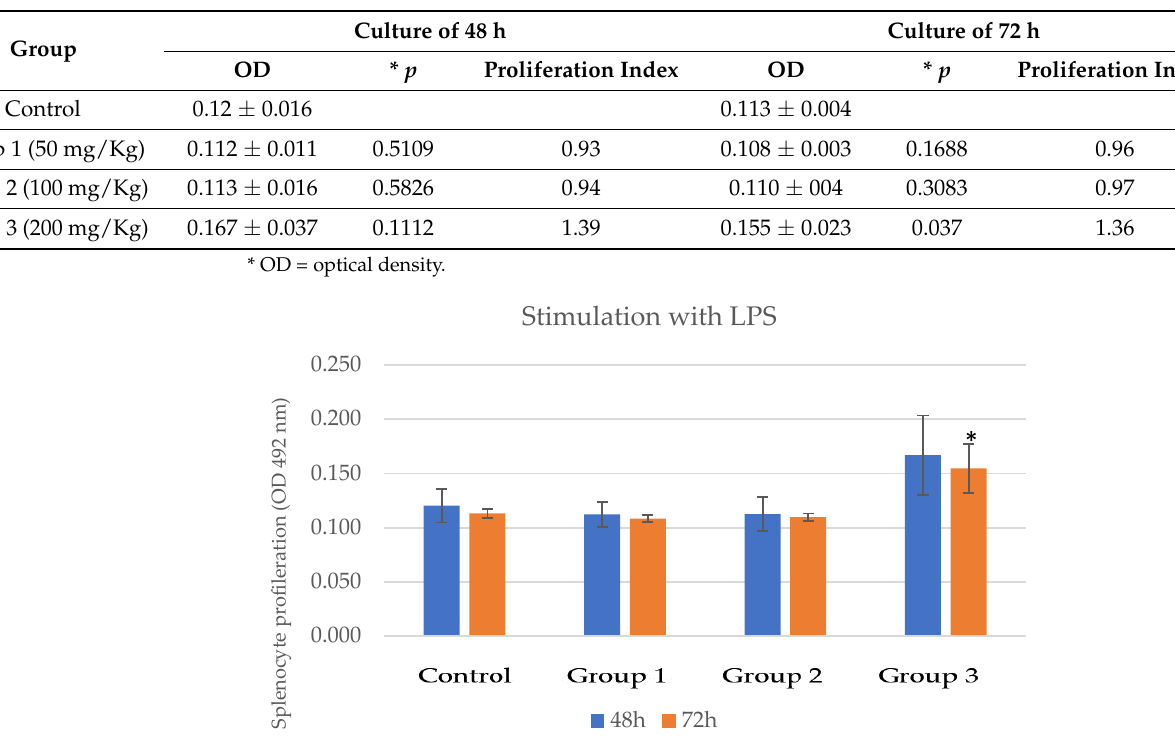
Table 14. Effect of the administration of the novel nutraceutical in three different concentrations on Figure 13. CD69 expression on lymphocytes in the groups that received ImunoBoost compared to mouse lymphocyte proliferation—stimulation with LPS. the control group—stimulation with conA; * = p value < 0.05.